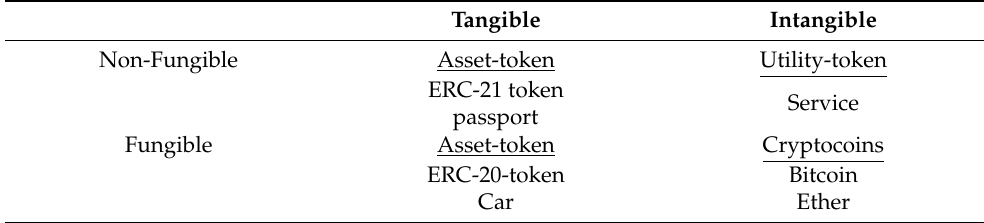
Table 1. Types of digital assets [17].